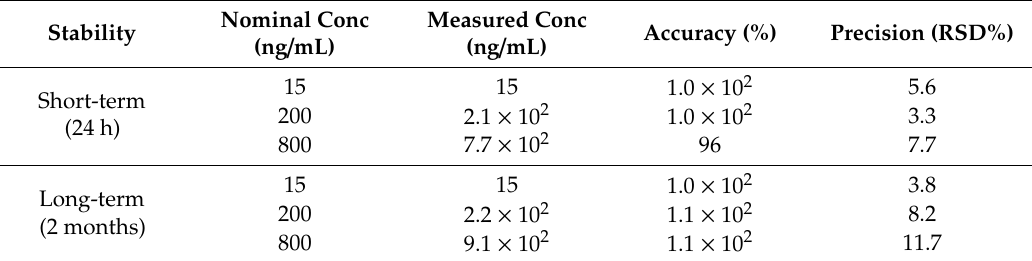
Table 4. Stability of lekethromycin under di ff erent storage conditions (n =